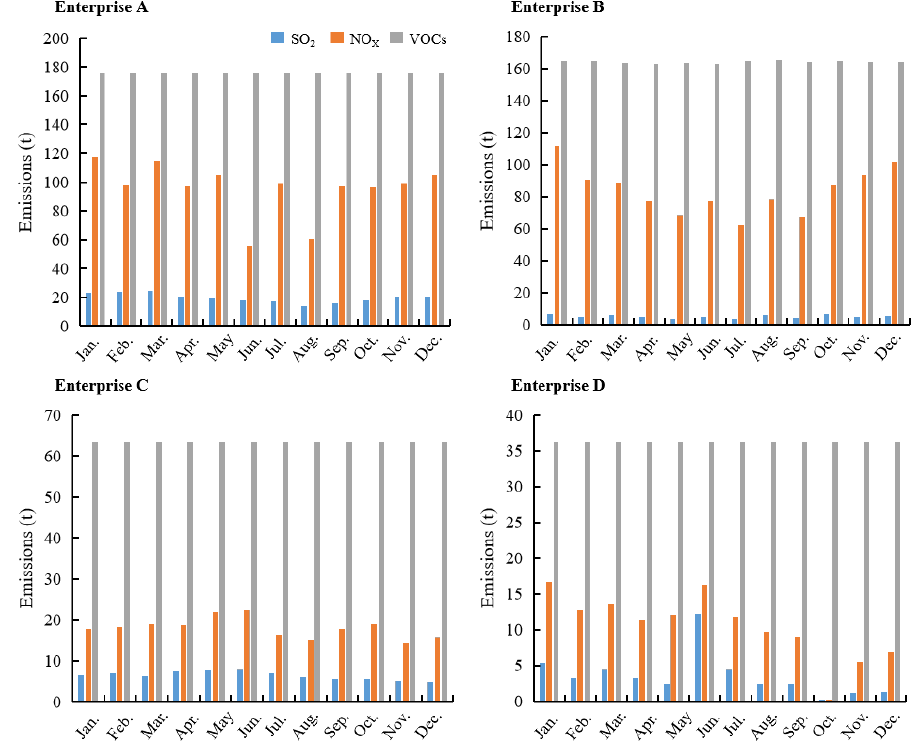
Figure 2. Seasonal emissions of main air pollutants from the four petrochemical enterprises.